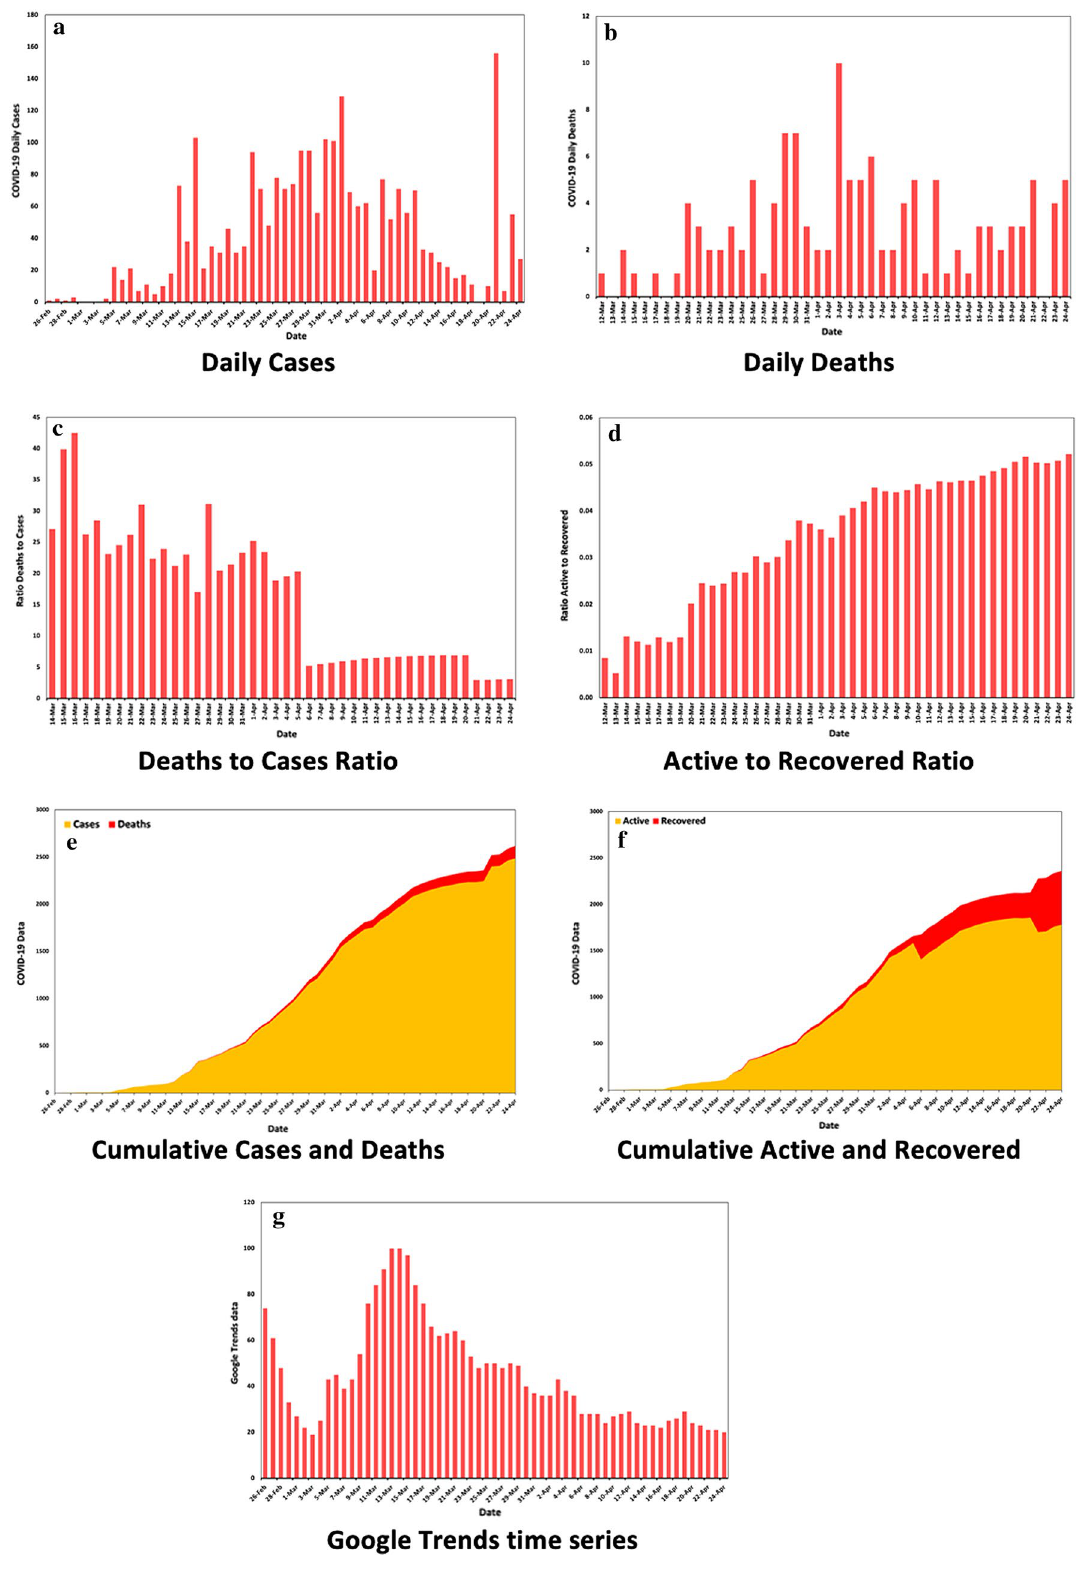
Figure 4. ( a ) Daily cases; ( b ) daily deaths; ( c ) deaths to cases ratio; ( d ) active to recovered ratio, ( e ) cumulative cases and deaths; ( f ) cumulative active cases and recovered; ( g ) Google Trends time